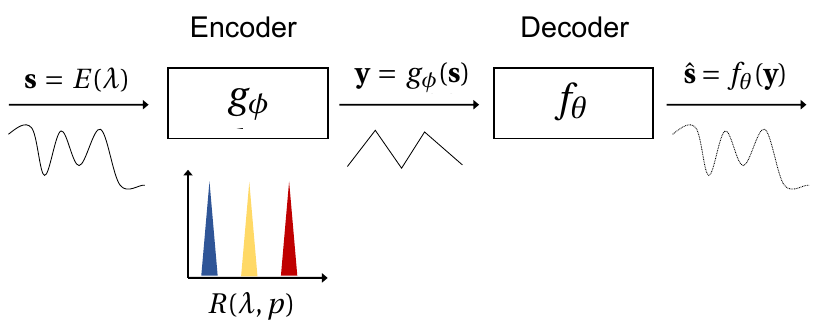
Figure 5.1: Spectrometry is the process of encoding spectral data to a measured dimension p from the infinite natural signal dimension. This process is visualized in the graphic above and written